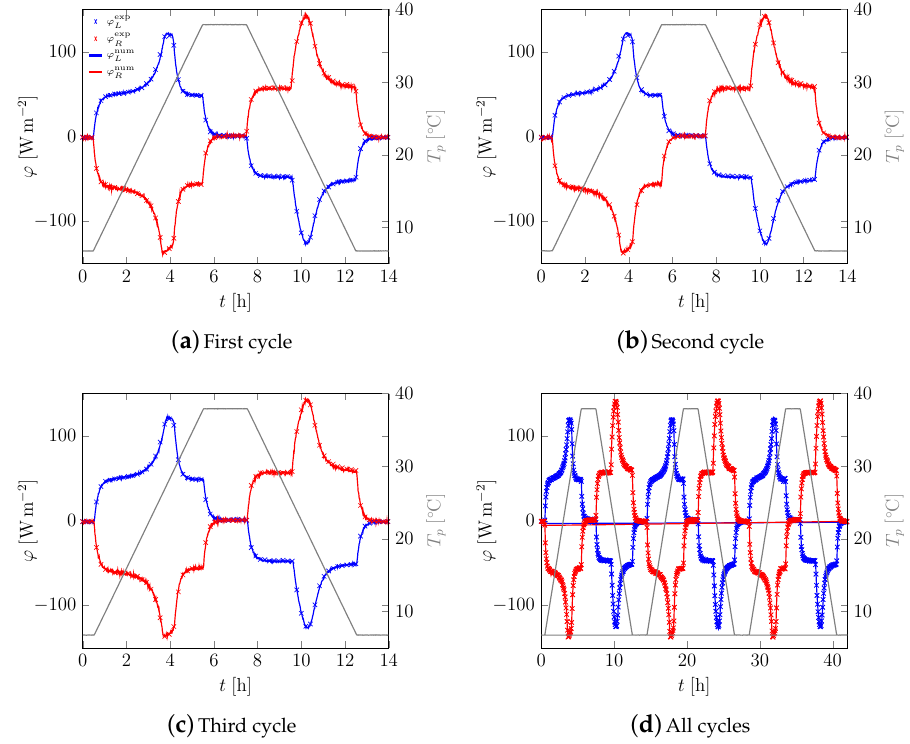
Figure A3. 12.4% w -PCM mortar: comparisons of the experimental fluxes with the numerical ones after identification for the 5h heating/cooling ramp